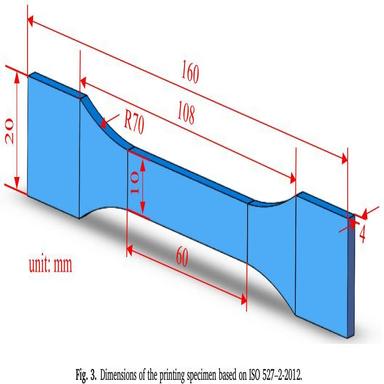
Three different categories of specimens on the α, β, and λ plane.